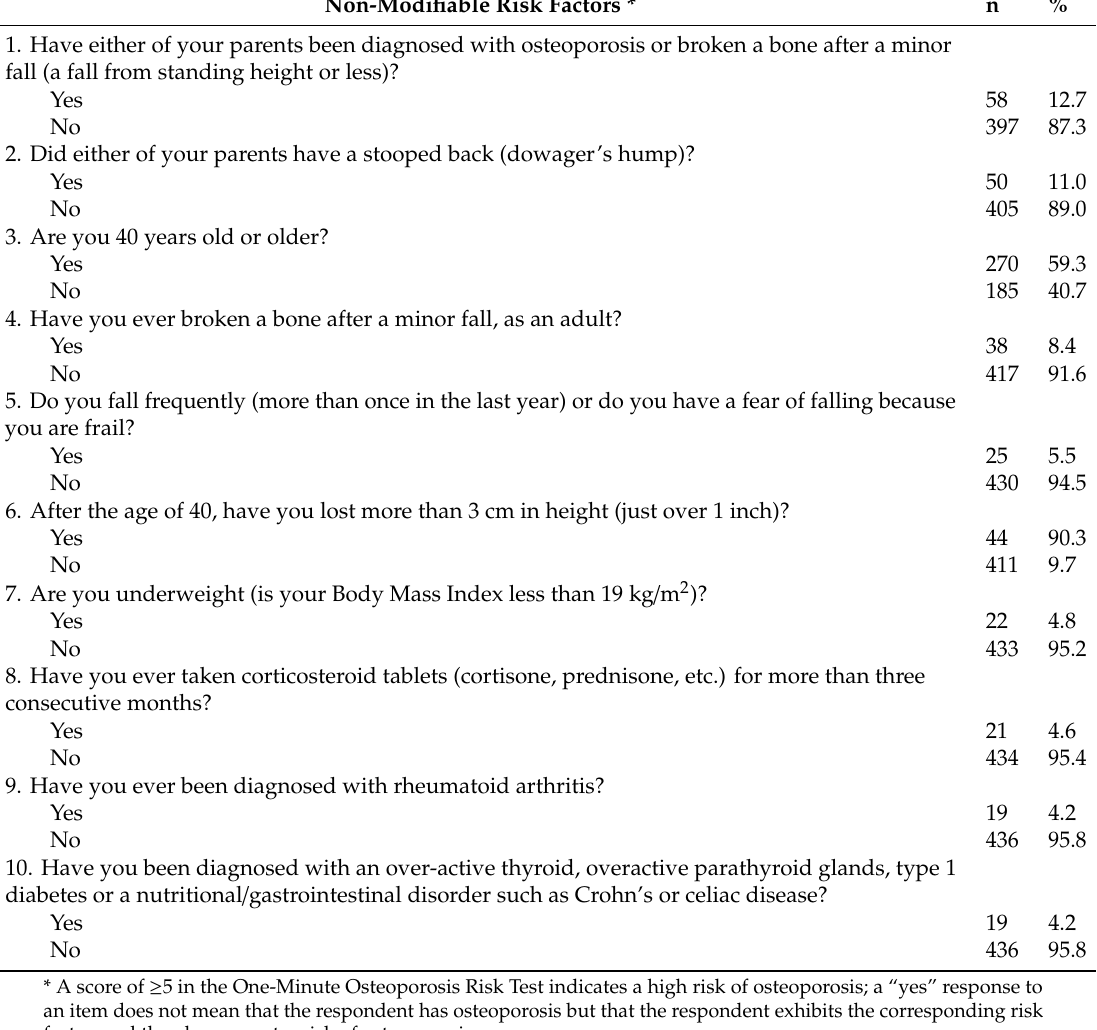
Table 2. International Foundation for Osteoporosis (IOF One-Minute Osteoporosis Risk Test of caregivers (n =